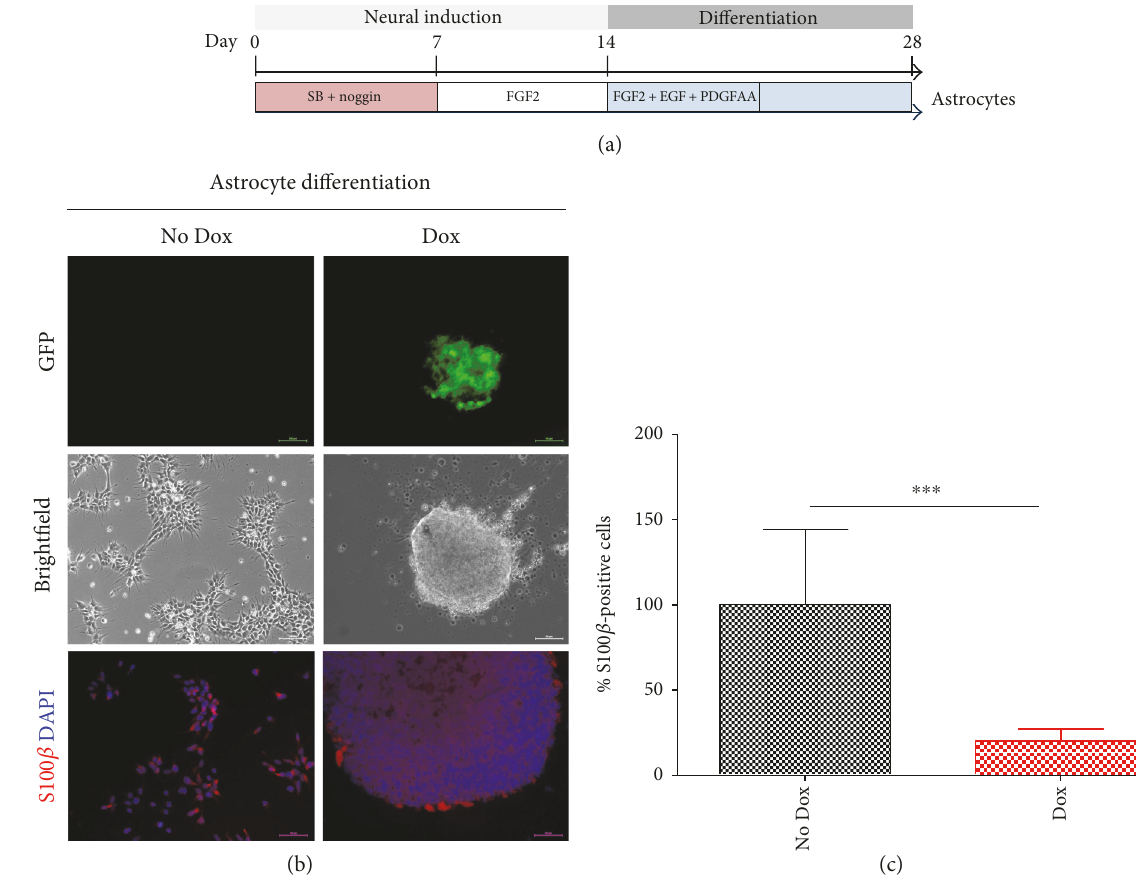
Figure 4: WDR62 knockdown e ff ects di ff erentiation to astrocytes. (a) Schematic diagram outlining protocol for hPSC di ff erentiation to astrocytes. (b) GFP, bright fi eld, and S100 β immunostaining images of WDR62 shRNA-transduced hPSC-derived astrocytes with versus without Dox treatment at the end of di ff erentiation. DAPI stains of nuclei are shown. Scale bars =50 μ m. (c) Quanti fi cation analyses of S100 β - positive cells suggesting signi fi cantly decreased ( P = 4 9 E − 04 ) di ff erentiation to astrocytes in Dox-treated group versus no Dox treatment controls ( n = 3 independent experiments). Two-tailed t -test was used to assess signi fi cance. ∗∗∗ P < 5 0 E − 04 . Dox: